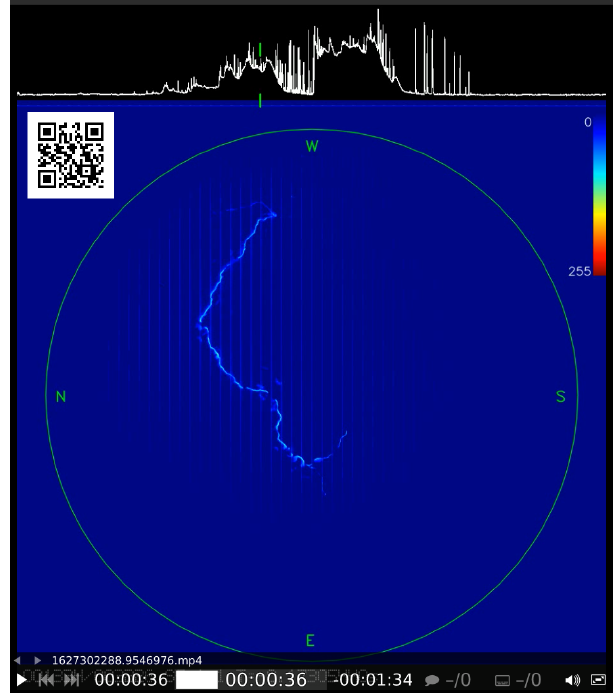
Figure 10. The reader is advised to use the inset QR code or the following link to run the video: https://doi.org/10.5446/60389 (Kakona,